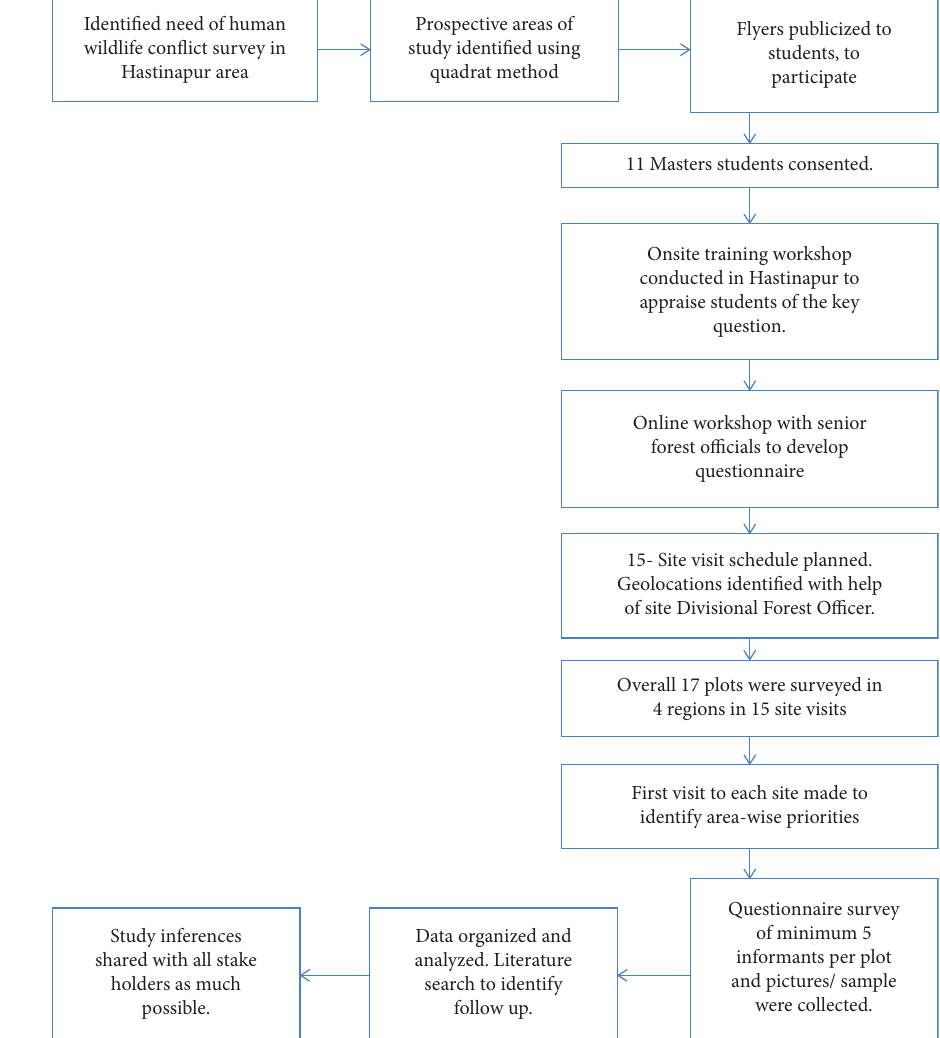
Figure 2: Flowchart to depict important activities and aspects of human-wildlife confict (HWC) in Hastinapur wildlife